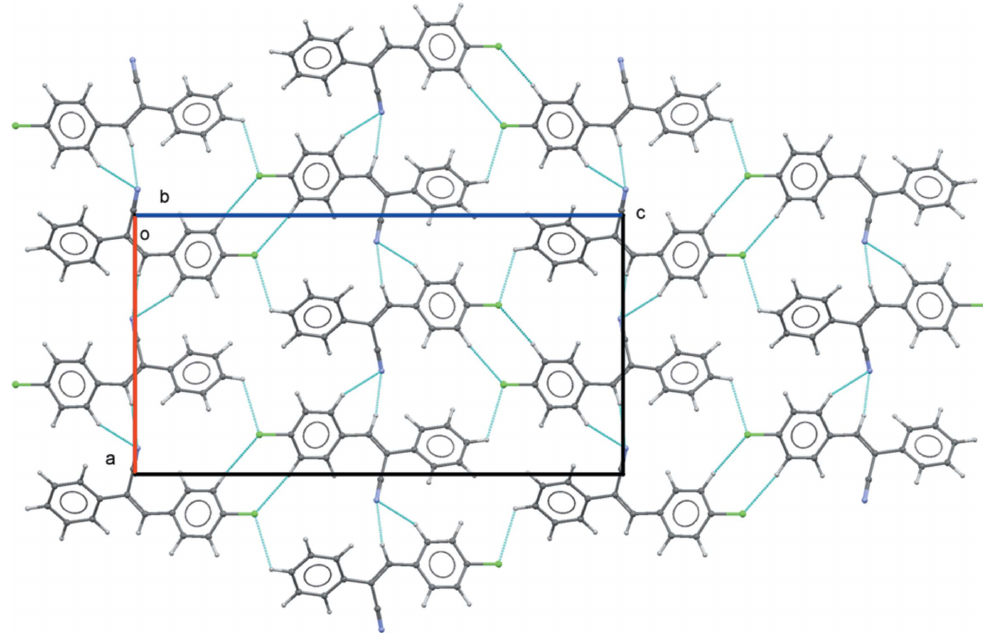
Figure 6 The molecular sheet assembled by intermolecular C—H (cid:2)(cid:2)(cid:2) N and C—H (cid:2)(cid:2)(cid:2) Cl interactions.